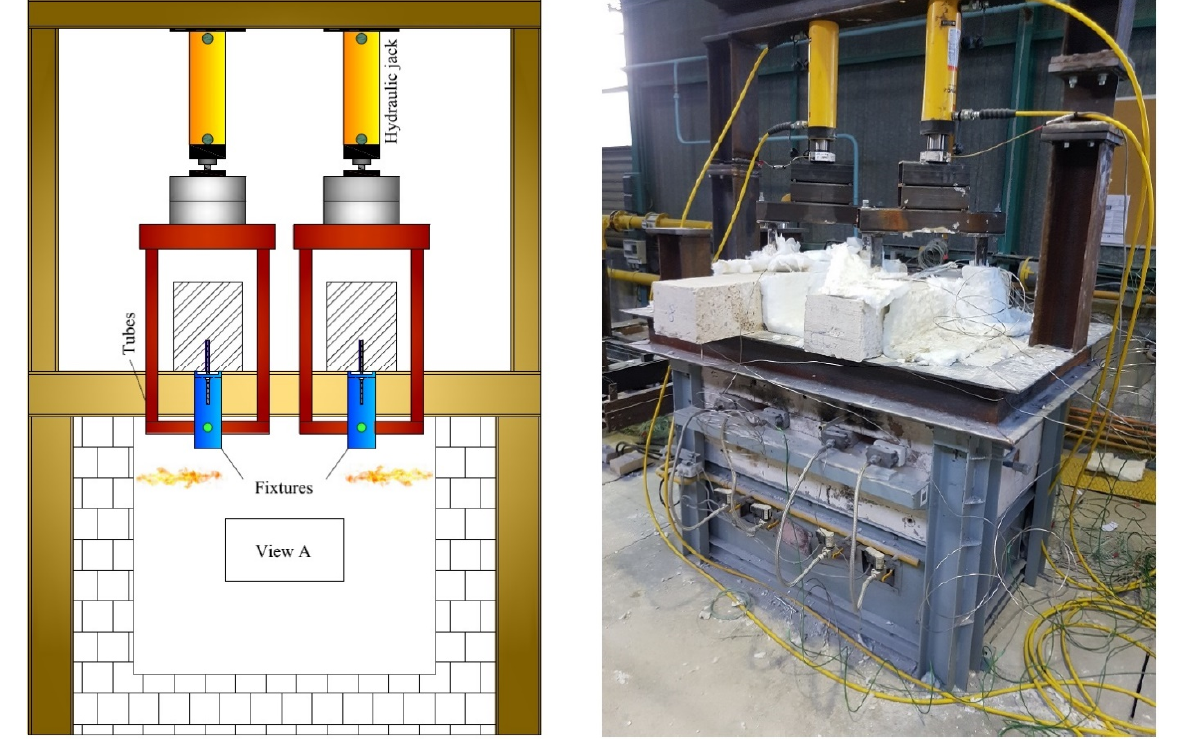
Figure 2. CSTB’s furnace and loading system for fire tests on bonded anchors [23].